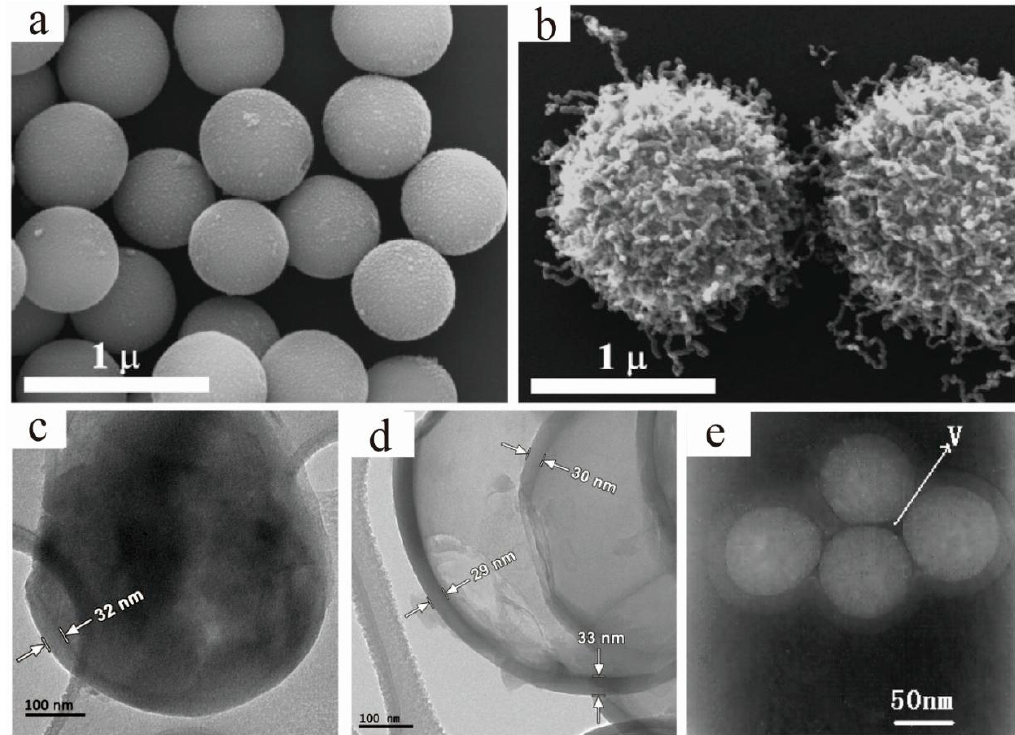
Figure 4. Scanning electron microscope (SEM) images of ( a ) SiO 2 /IO microspheres and ( b )